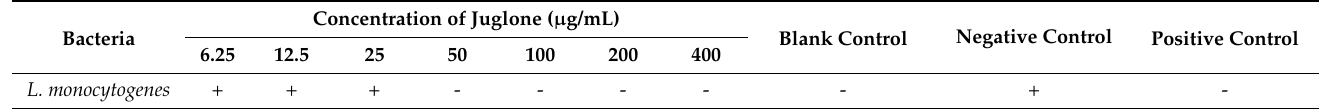
Table 1. Growth of L. monocytogenes .